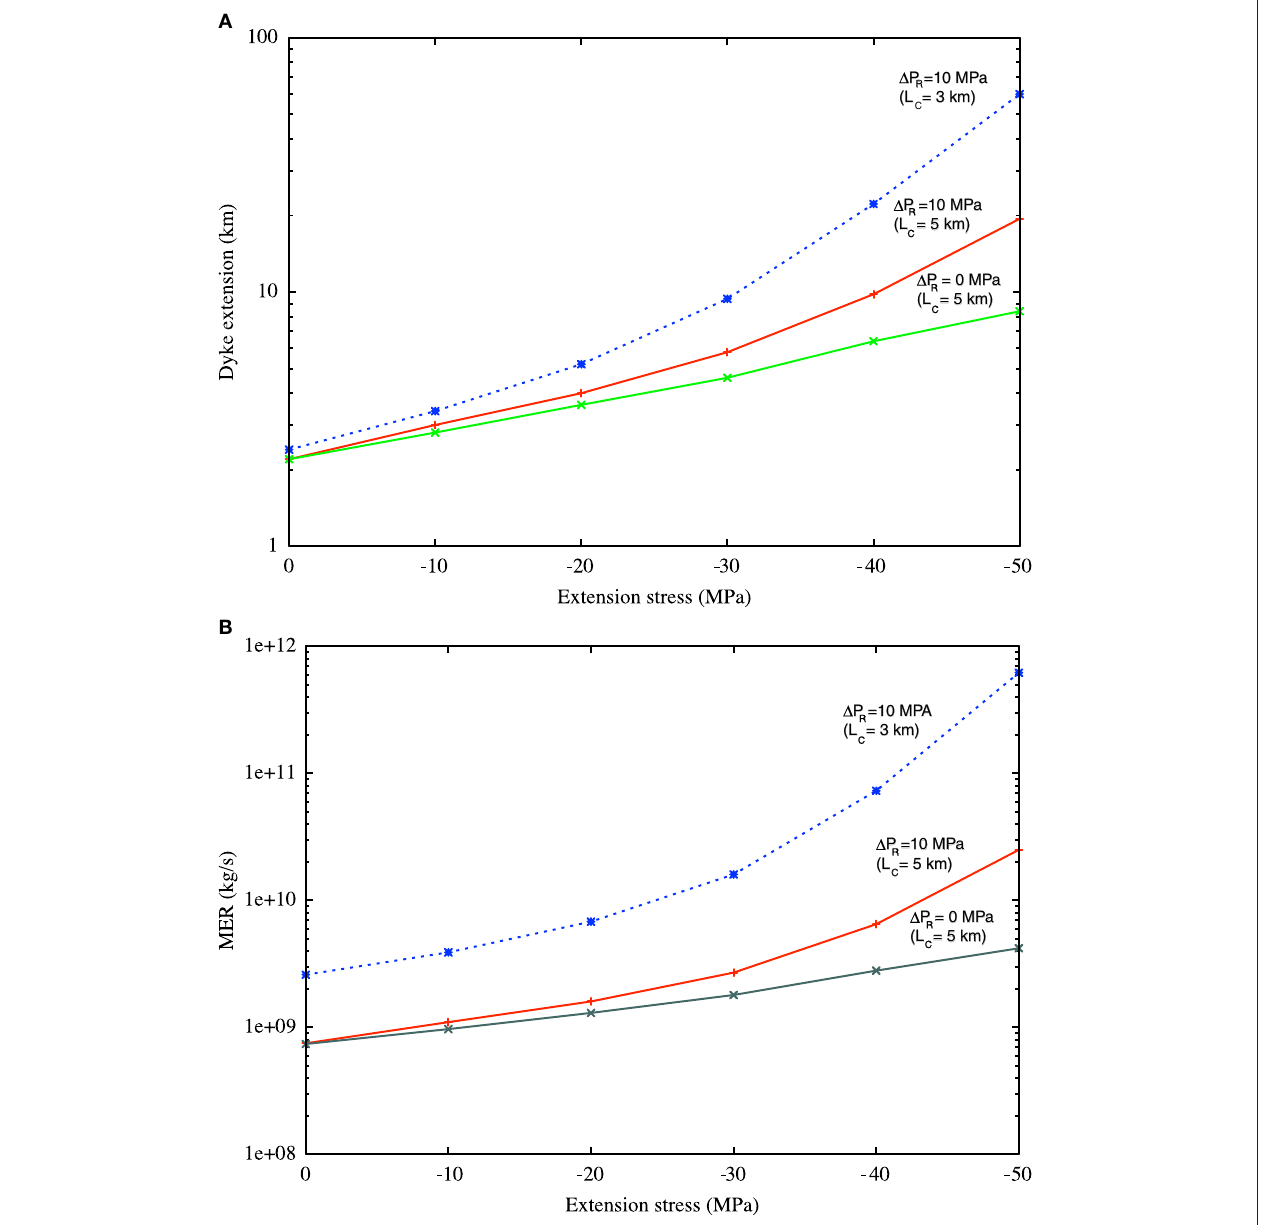
FIGURE 4 | Effects of extensional far-field stress on (A) maximum sustainable length of the shallow dyke conduit and (B) MER. (A) Maximum sustainable lengths of the shallow dyke conduit depend on the extensional far-field stress and magma reservoir overpressure, ranging from a few to a few tens kms. (B) Similarly maximum MERs are a function of the extensional stress and magma reservoir overpressure, ranging from 10 9 to 10 11